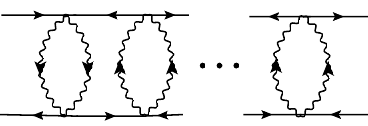
Figure 2 . The ladder diagrams that dominate the 4-point correction functions of the vector (cid:12)elds. The solid and wavy lines represent the vector and tensor (cid:12)eld